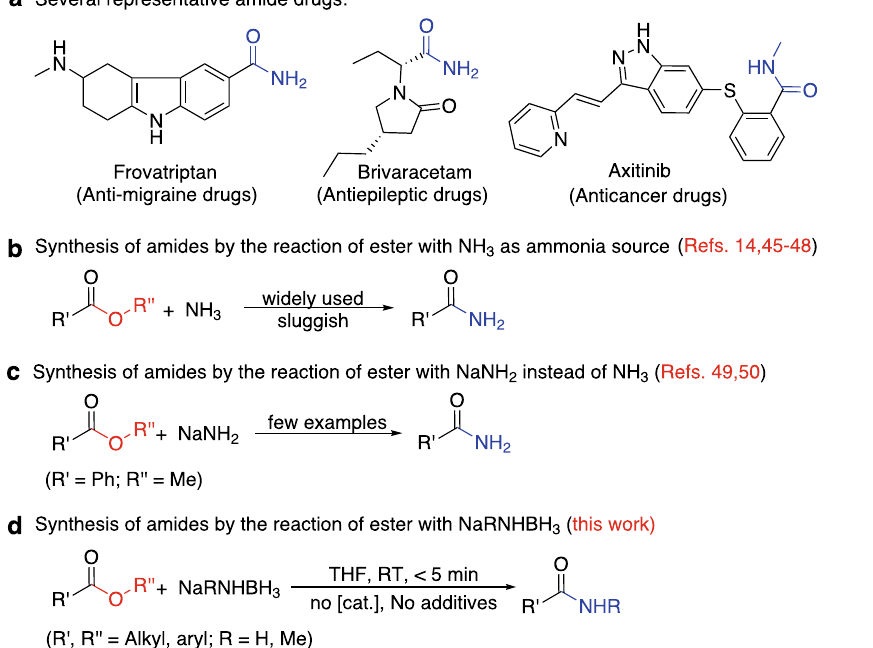
Fig. 1 Various synthetic methods for amide bonds. a Several representative amide drugs. b Synthesis of amides by the reaction of ester with NH 3 as ammonia source. c Synthesis of amides by the reaction of ester with NaNH 2 instead of NH 3 . d Synthesis of amides by the reaction of ester with NaRNHBH 3 (R = H,